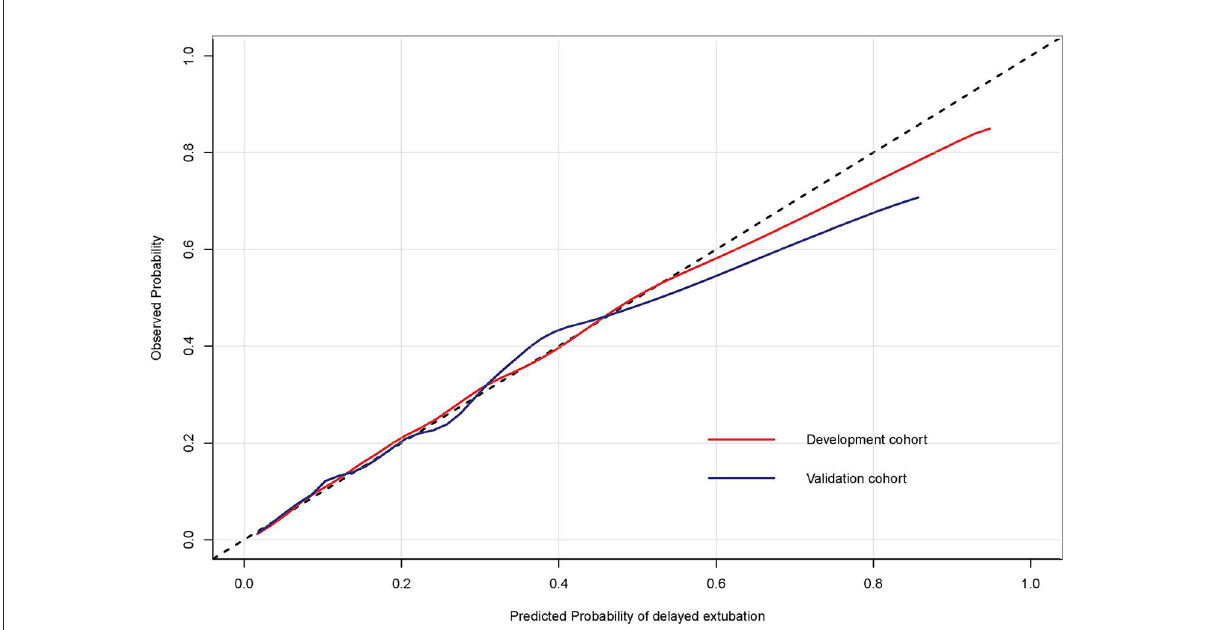
FIGURE4 The calibration curves of the risk prediction model of delayed extubation. The diagonal dashed line indicated perfect prediction of the ideal model. The solid line represented the performance of the model in the development and validation cohorts, and being closer to the diagonal dashed line indicated that the model has better prediction ability.